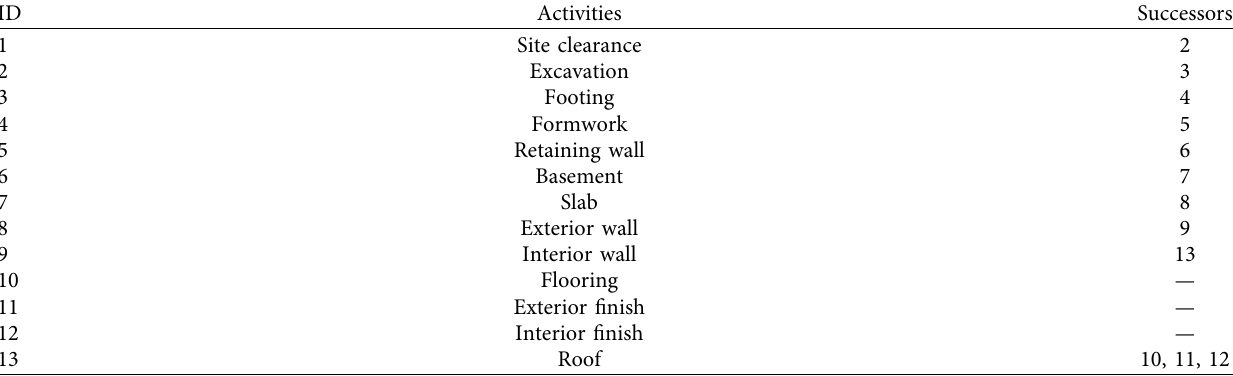
Table 1: Specifc activities method of case 1.